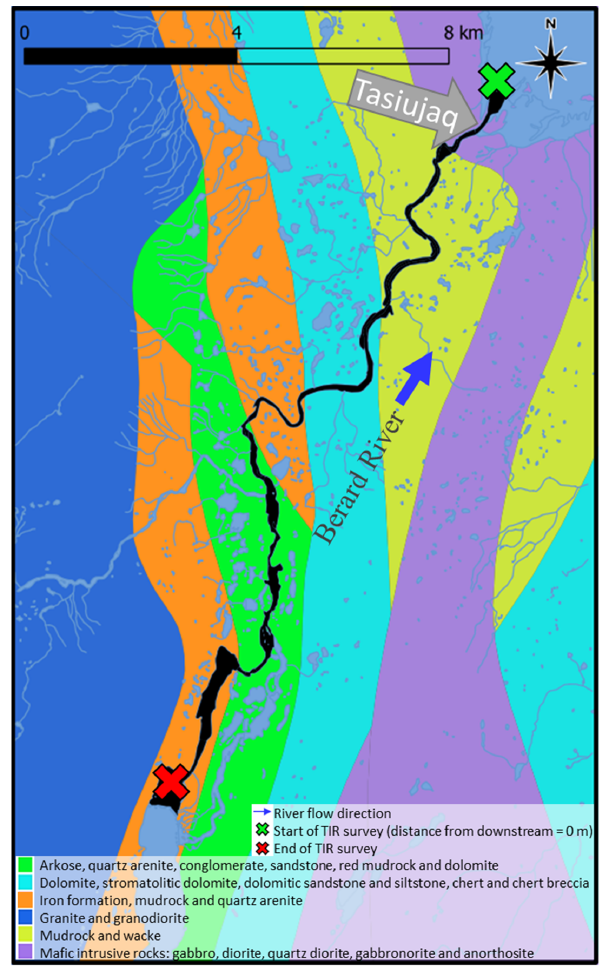
Figure 3. Bedrock geology across the Berard River (based on [36]).